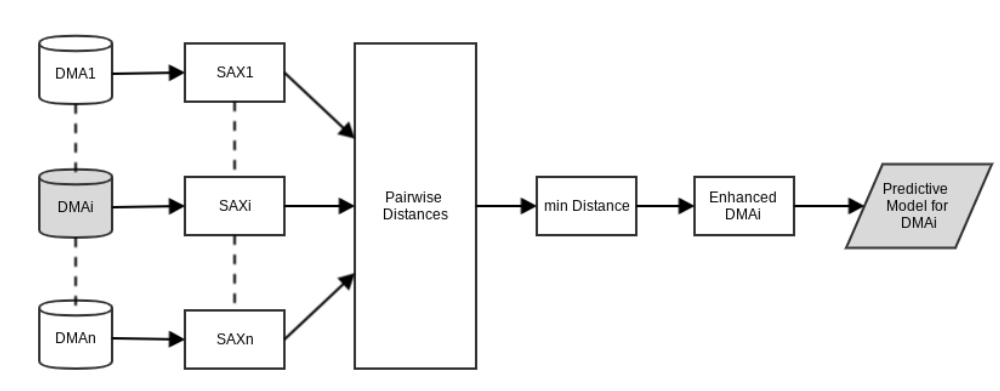
Figure 3. Flowchart of the overall process for enhancing DMA-demand predictive